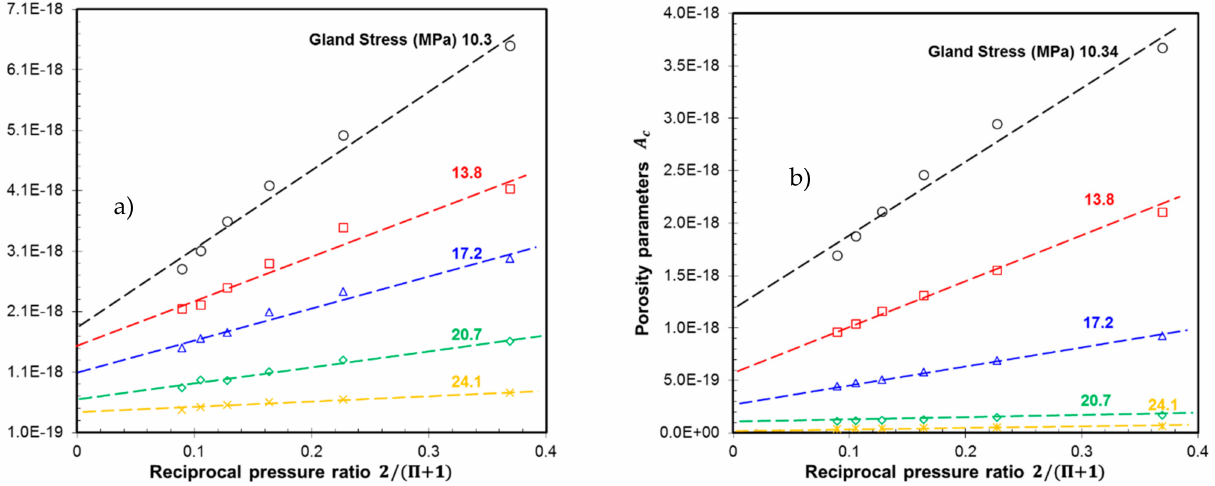
Figure 5. Graphs to obtain porosity parameters. ( a ) Flexible graphite, ( b ) die